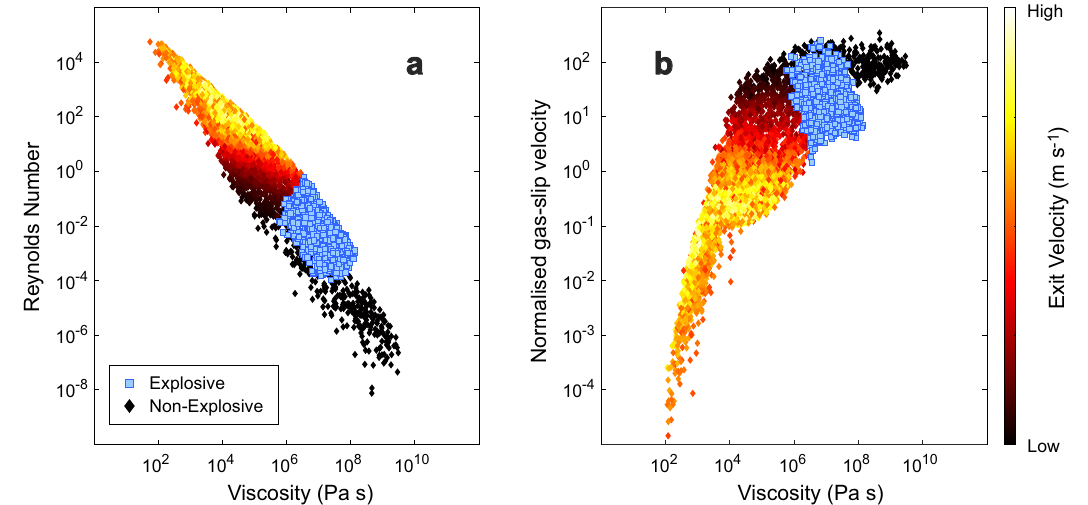
Fig. 10 Plots showing the correlation between output parameters, obtained from the sensitivity analysis. The correlation between viscosity and ( a ) Reynolds number and the ( b ) normalised gas-slip velocity is shown. Explosive solutions are shown by the blue squares. Non-explosive solutions are shown by the diamonds, coloured by exit velocity. For the explosive solutions, all parameters represent the value at fragmentation, whilst for the non-explosive solutions, all parameters represent the value at the vent. In ( b ) gas-slip velocity is normalised by melt